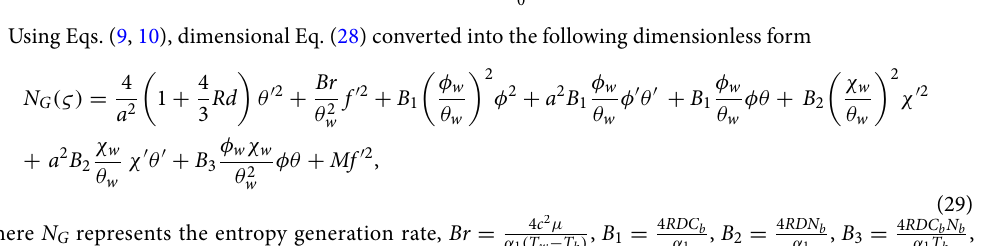
( T a ( C a T b ) C b ) N a N b φ w χ w − − − T b , C b , N = = =